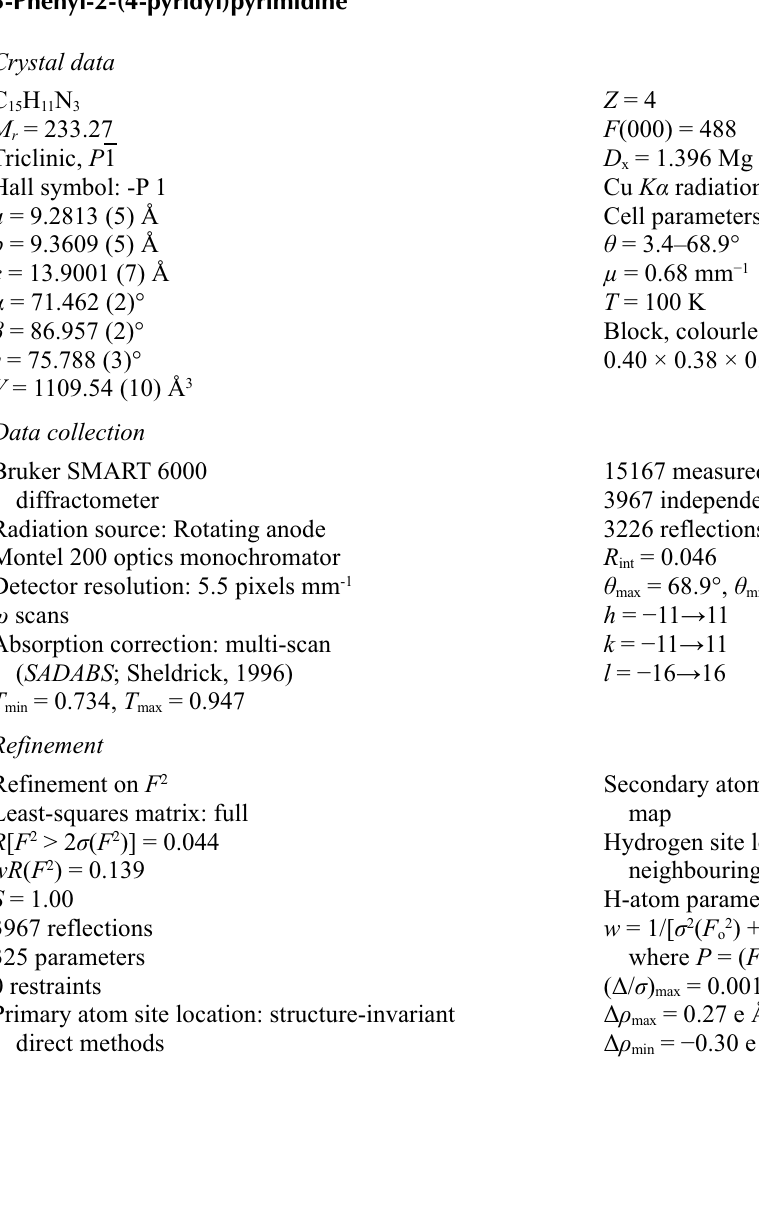
The reaction scheme for the title